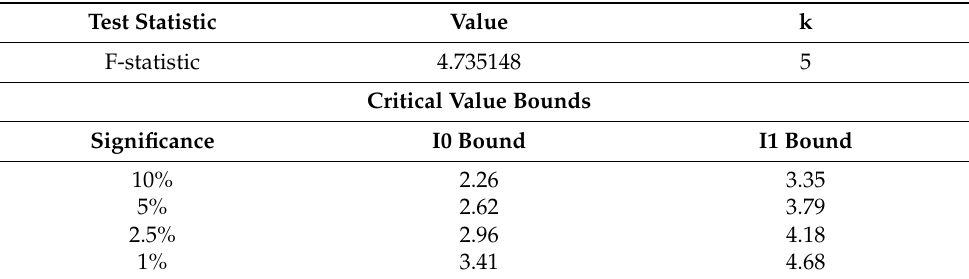
Table 3. Bounds testing for the validation of